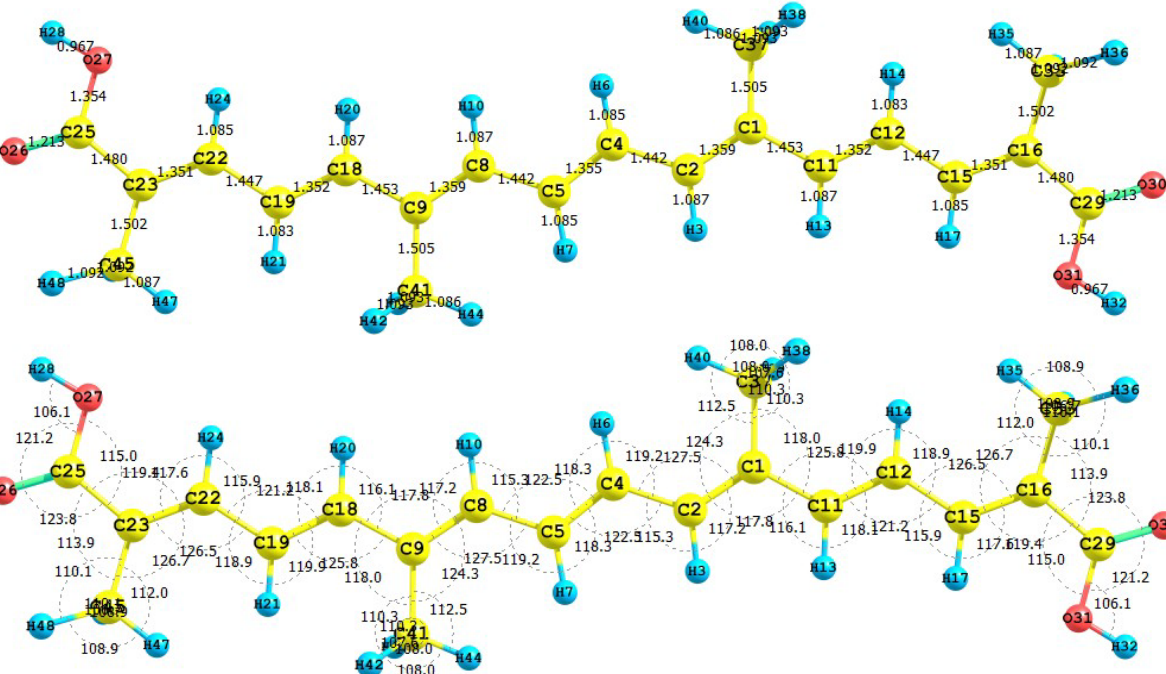
Figure 1. Interatomic bond distances ( Å ) and bond angles (deg) for the crocetin